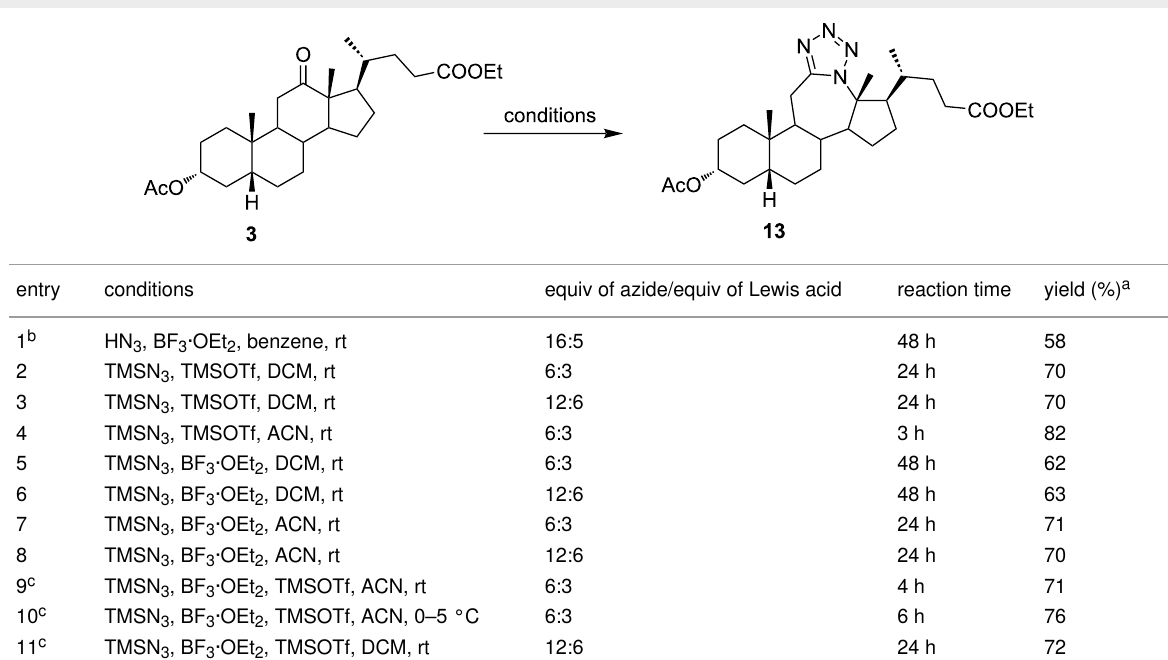
Table 1: Optimization of reaction conditions for the transformation of